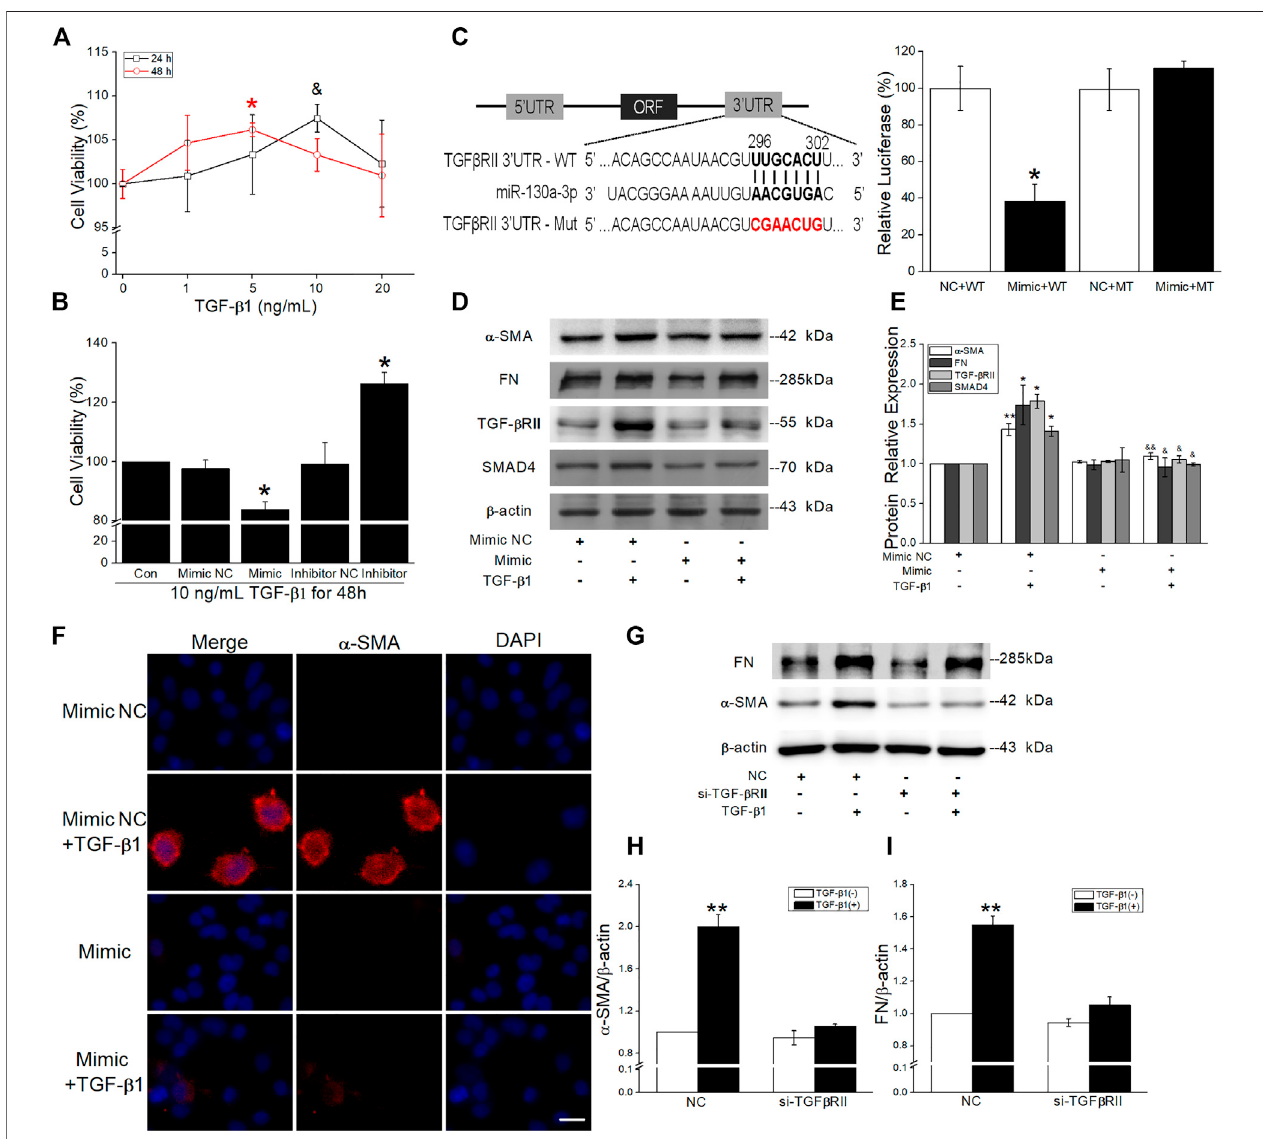
FIGURE9| EffectofmiR-130a-3ponthedifferentiationinTGF- β 1-inducedMRC-5. (A-B) CCK-8assaywasusedtodetectcellviabilityofMRC-5cellsunderTGF- β 1 stimulation, and the data for 0 ng/ml or control group wasset to 100%. * p < 0.05, versus0 ng/ml (48 h)or the control group; & p < 0.05, versus 0 ng/ml (24 h), by the Mann – Whitney U test, n =3 – 5. (C) PredictedbindingsitesofmiR-130a-3pwithTGF- β RII-3 ′ UTR(left).DualluciferasereporterassaysofmiR-130a-3pandTGF- β RII.* p < 0.05, versus the NC + WT group, one-way ANOVA followed by Bonferroni ’ s test, n = 3 – 4. (D-E) Representative and statistical data of α -SMA, FN, TGF- β RII, and SMAD4proteinsinMRC-5aftertransfectionofmiR-130a-3pmimic.* p < 0.05,** p < 0.01,versustheMimicNCgroup; & p < 0.05, && p < 0.01,versustheMimicNC+TGF group,bytheMann – Whitney U test,n=4 – 6. (F) Immuno fl uorescencestainingfor α -SMAaftermiR-130a-3pmimicadministration. α -SMA-positive(red)andDAPI(blue). Scale bar = 50 μ m. (G-I) Representative and statistical data of α -SMA and FN proteins in MRC-5 after transfection of small interfering RNA for TGF- β RII (si-TGF- β RII). ** p < 0.01, versus NC group, by the Mann – Whitney U test, n =